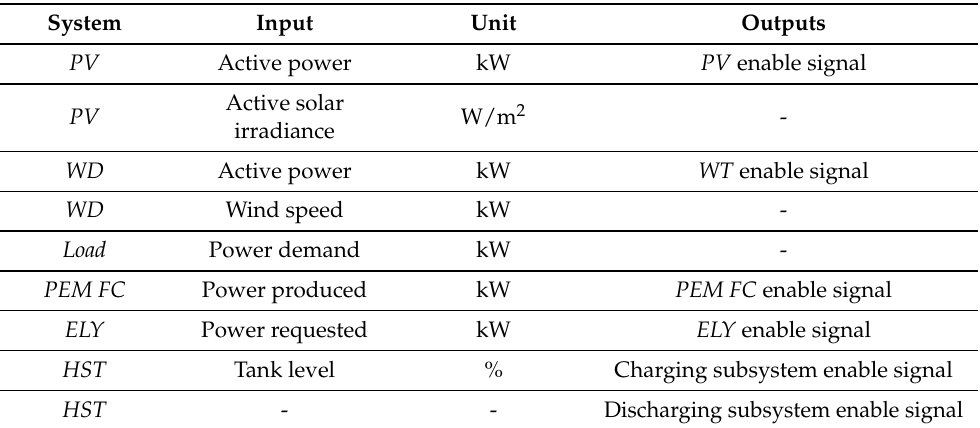
Table 6. Inputs and outputs of